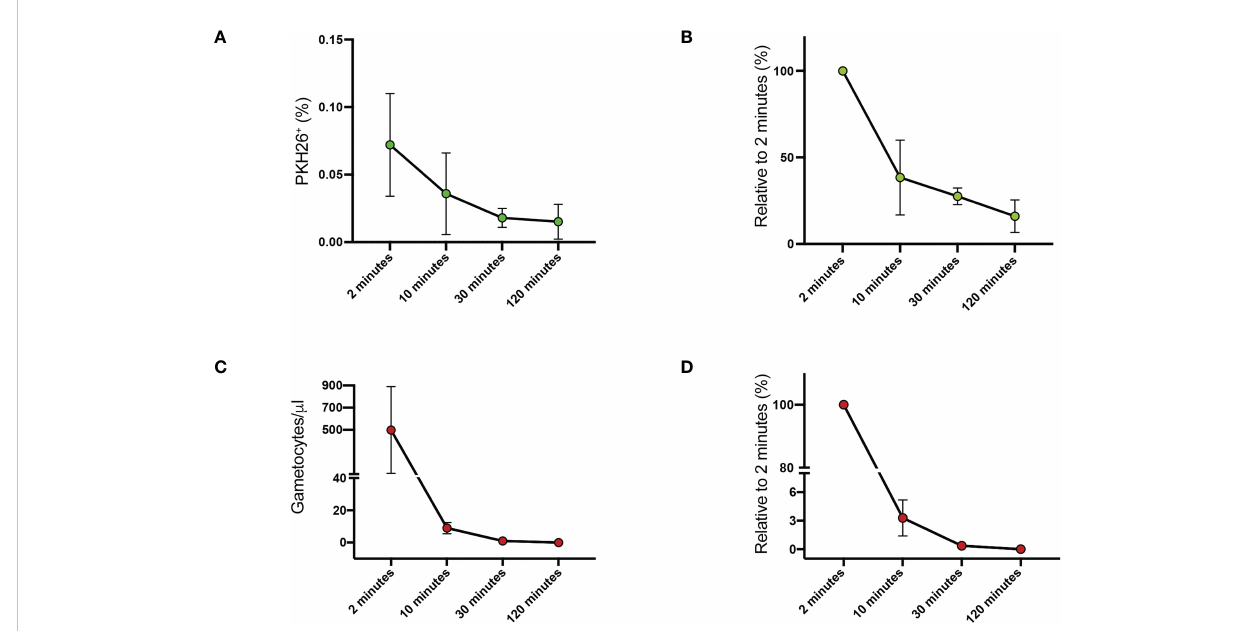
FIGURE 1 Clearance of PHK26+ P. falciparum stage II-III gametocytes from mouse peripheral blood at 2, 10, 30 and 120 minutes (A) Average of the fl ow cytometry counts from the two mice. (B) Flow cytometry counts of stage II-III gametocytes expressed as percentage relative to 2-minute value. (C) Stage II-III gametocytes per m l counted on Giemsa-stained blood smears. (D) Stage II-III gametocytes counted on Giemsa-stained blood smears expressed as percentage relative to 2-minute value. All data in (A – D ) are presented as the mean ±